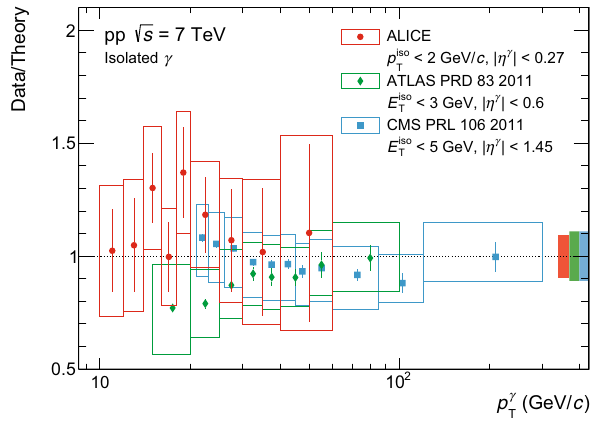
Fig. 9 Ratio between differential cross section measurements and the- ory predictions for ATLAS [11], CMS [7] and ALICE. Theory predic- tionsareobtainedwithJETPHOXandCTEQ6.6PDFs[54]forATLAS, and JETPHOX and CT14 PDFs [50] for CMS and ALICE. Only experi- mental uncertainties are shown here. Error bars are statistical and boxes are the quadratic sum of statistical and systematic uncertainties. The normalisation uncertainty of each experiment is presented as an overall box around unity